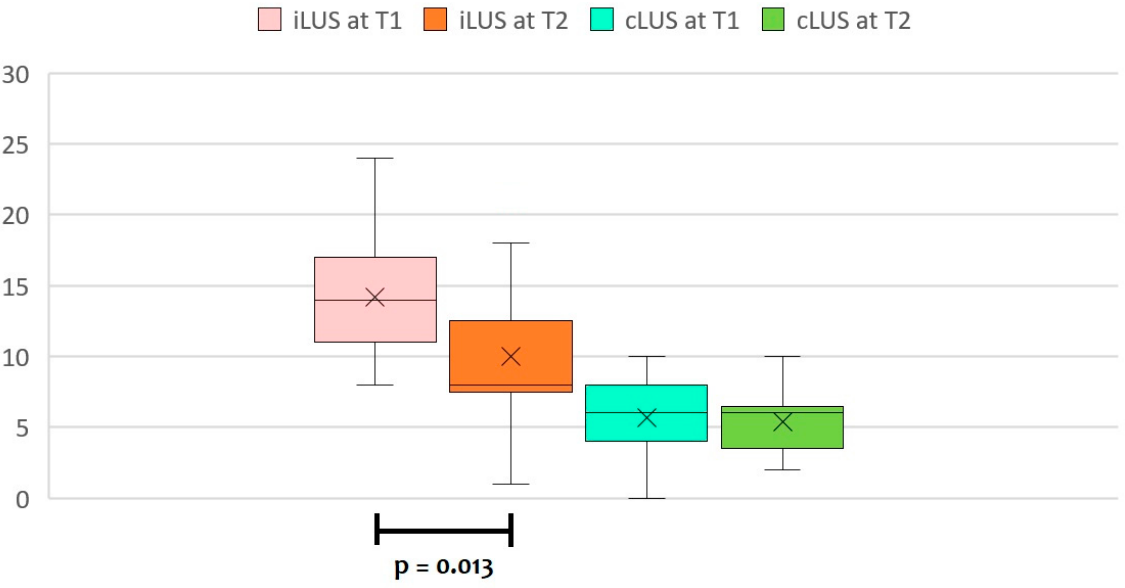
Figure 3. The median CDH-LUS score for the lung affected by CDH (ipsilateral CDH-LUS score, iLUS) and for the contralateral lung (contralateral CDH-LUS score, cLUS) at T1 (24–48 h of life) and T2 (within 12 h of surgical repair).